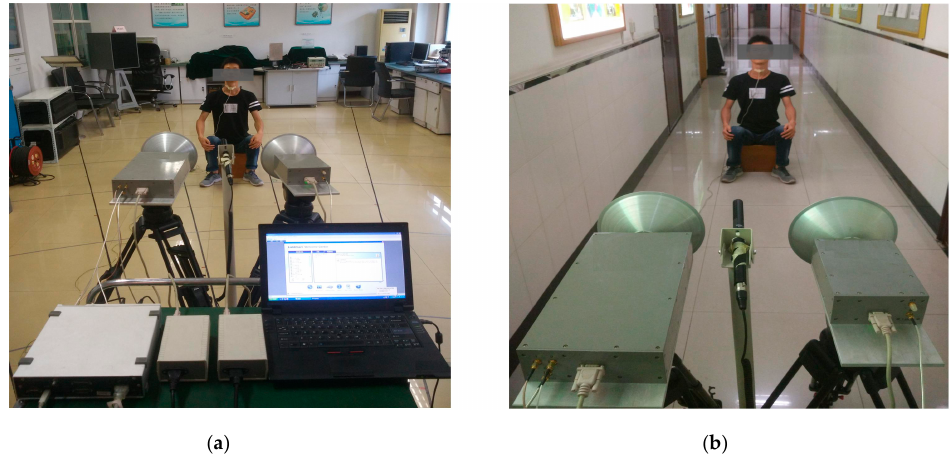
Figure 4. Experimental scenarios of the vocal vibration signal and acoustic signal detection: ( a ) enclosed room (2 m); ( b ) corridor (2 m). room (2 m); ( b ) corridor (2